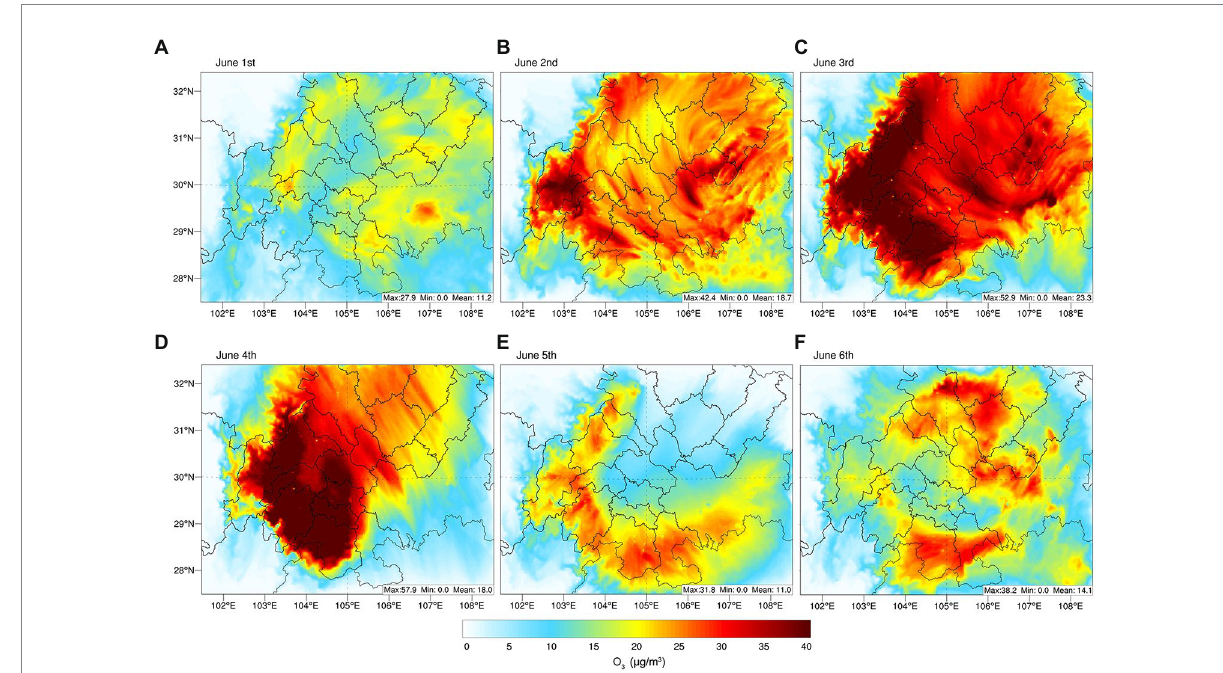
FIGURE 5 (A-F) BVOC contributions to ground-level MDA8 O 3 over the SCB from 1 June to 6 June, 2019.